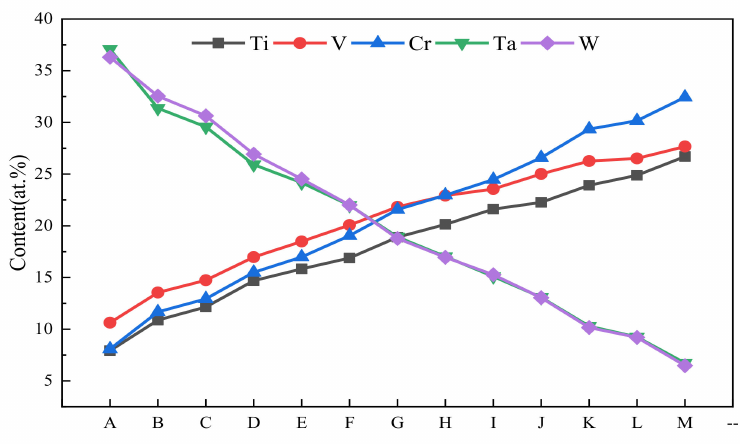
Figure 1. Variations in alloy compositions of (TiVCr)x-(TaW)1-x (A-M) binary system HEA films.